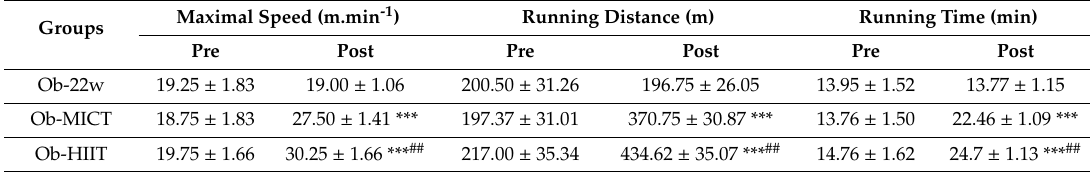
Table 2. E ff ect of exercise training on exercise